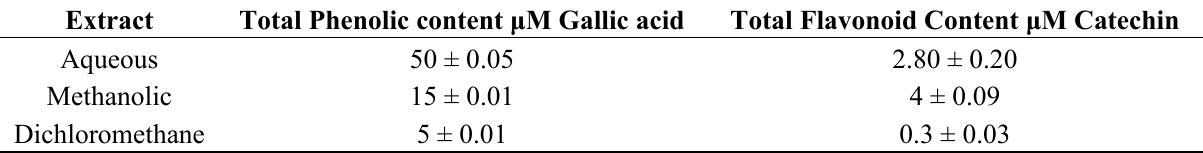
Table 1. Total polyphenols and total flavonoids in three different extracts of leaves of Momordica foetida Schumach. et